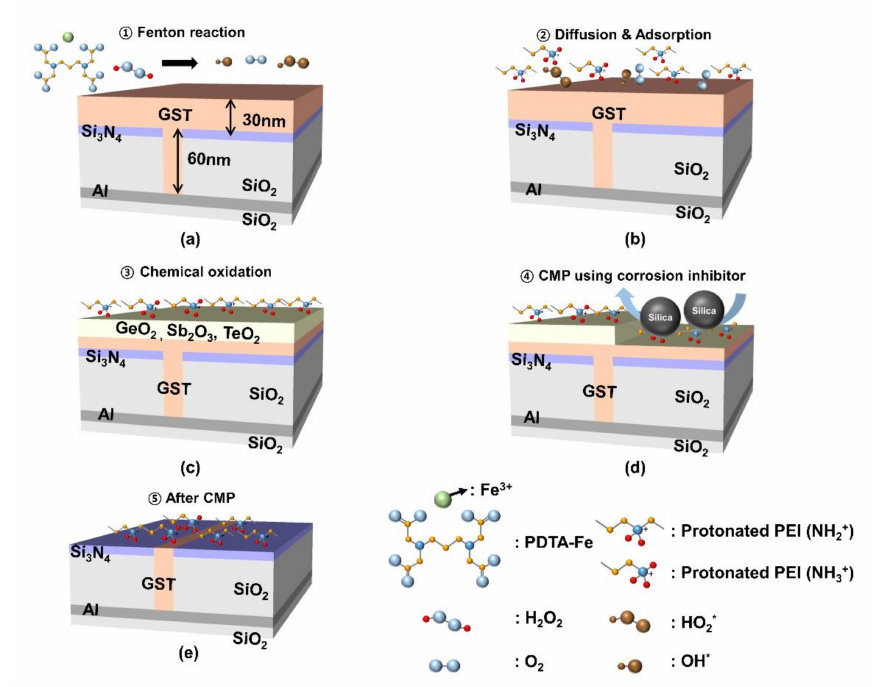
Figure 10. Schematic Ge 1 Sb 4 Te 5 film surface CMP mechanism using Fenton reaction and corrosion inhibitor. ( a ) Fenton reaction between ferric–ionic catalyst and H 2 O 2 on as sputtered Ge 1 Sb 4 Te